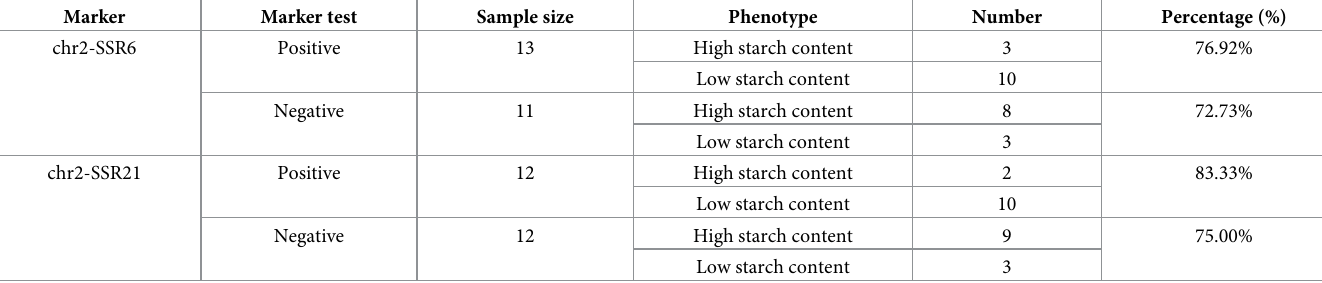
Table 6. Statistics of phenotype and mark detection results of starch in potato variety and strains.